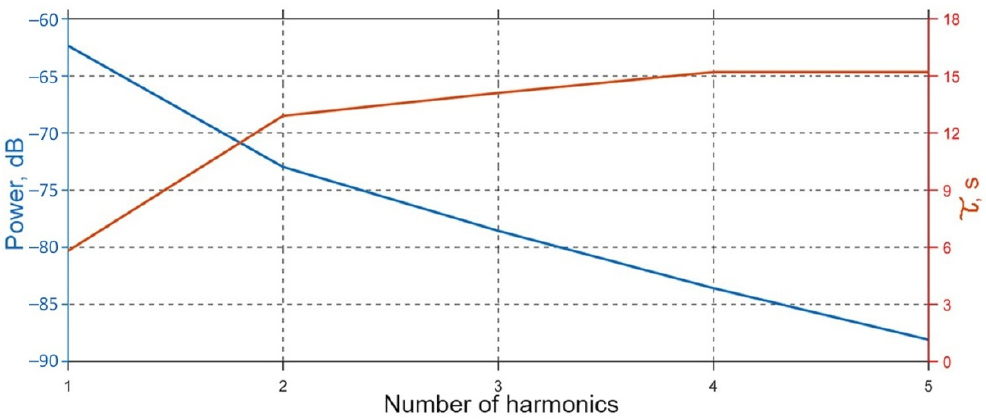
Figure 5. The power of downshifted spectral structures, averaged through the pump cycle, from 15:46 to 15:56 UT, and the delay in time of occurrence the spectral structures depending on the harmonic number.